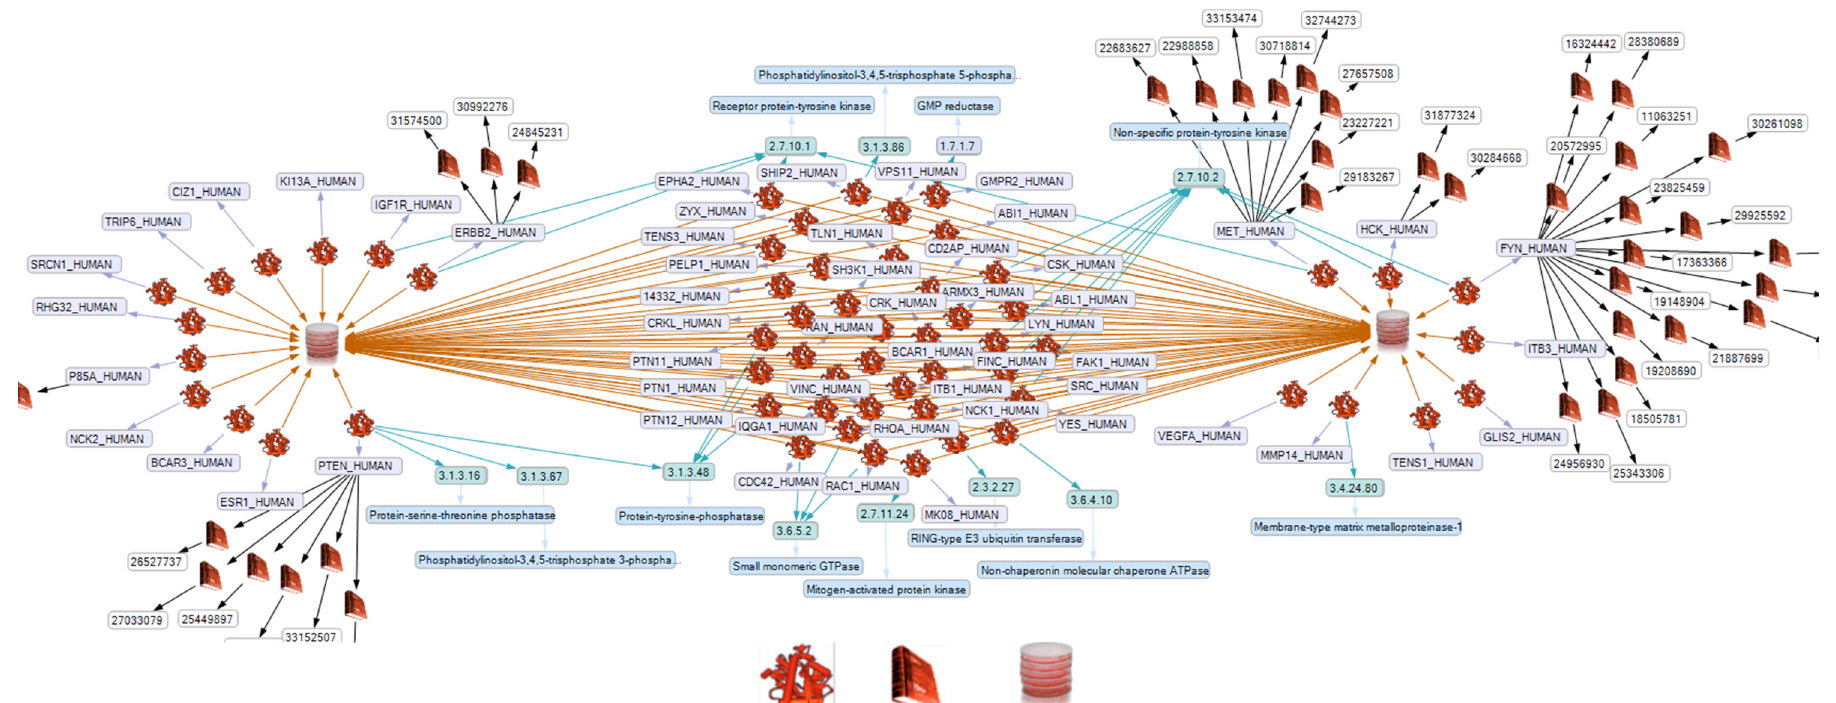
Figure 1. Types of enzymes included in the list of selected proteins and related to BCAR1 from MCF-7 and FTC-133 cells. Proteins are identified by SwissProt entry names (for their accession numbers and gene names, see Table 1). Activities are given in enzyme classification numbers EC (green squares) and terms (blue squares). The various icons used in Figure 1 are shown below the graph at higher magnification. The left icon of the bottom line represents proteins named by their entry names within the figure. The middle icon indicates a publication, which is identified by the PMID number within the nearby white box. The PMID numbers identify those publications, which indicate that the respective protein contains an intrinsically disordered domain. The cell dish icon at the right side of the bottom indicates the origin of the cells. Within the figure, brown lines show the link of the protein to the origin cell lines MCF-7 (left side cell dish icon) and FTC-133 (right side cell dish icon). To see details, please zoom in.